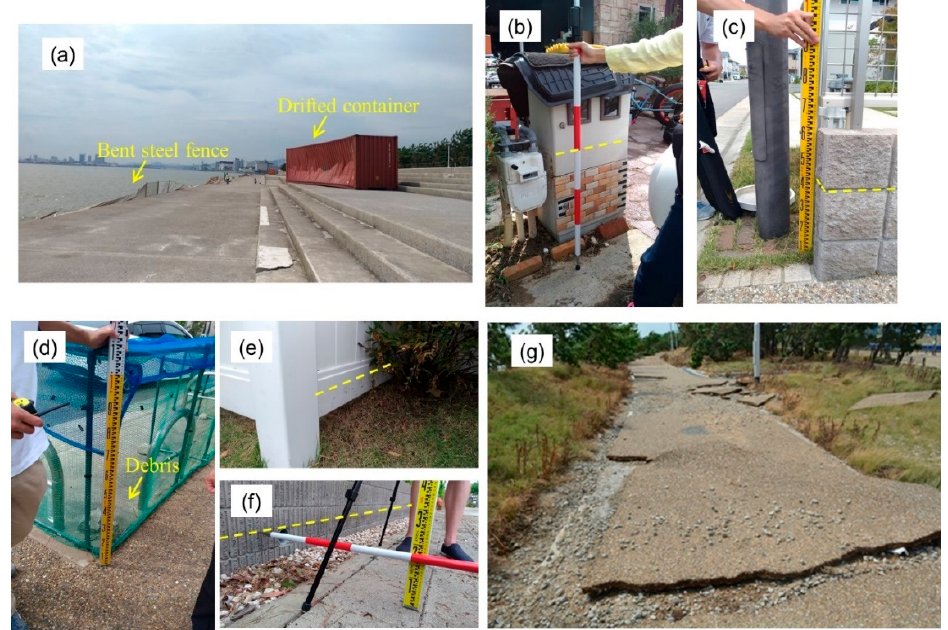
Figure 8. Photographs taken by the authors at Suzukaze town. ( a ) Damaged steel barrier and drifted shipment container at the embankment; ( b – f ) Survey Points S1–S5, respectively (watermark is highlighted with a yellow dashed line); ( g ) Eroded pedestrian road near the coastal embankment.